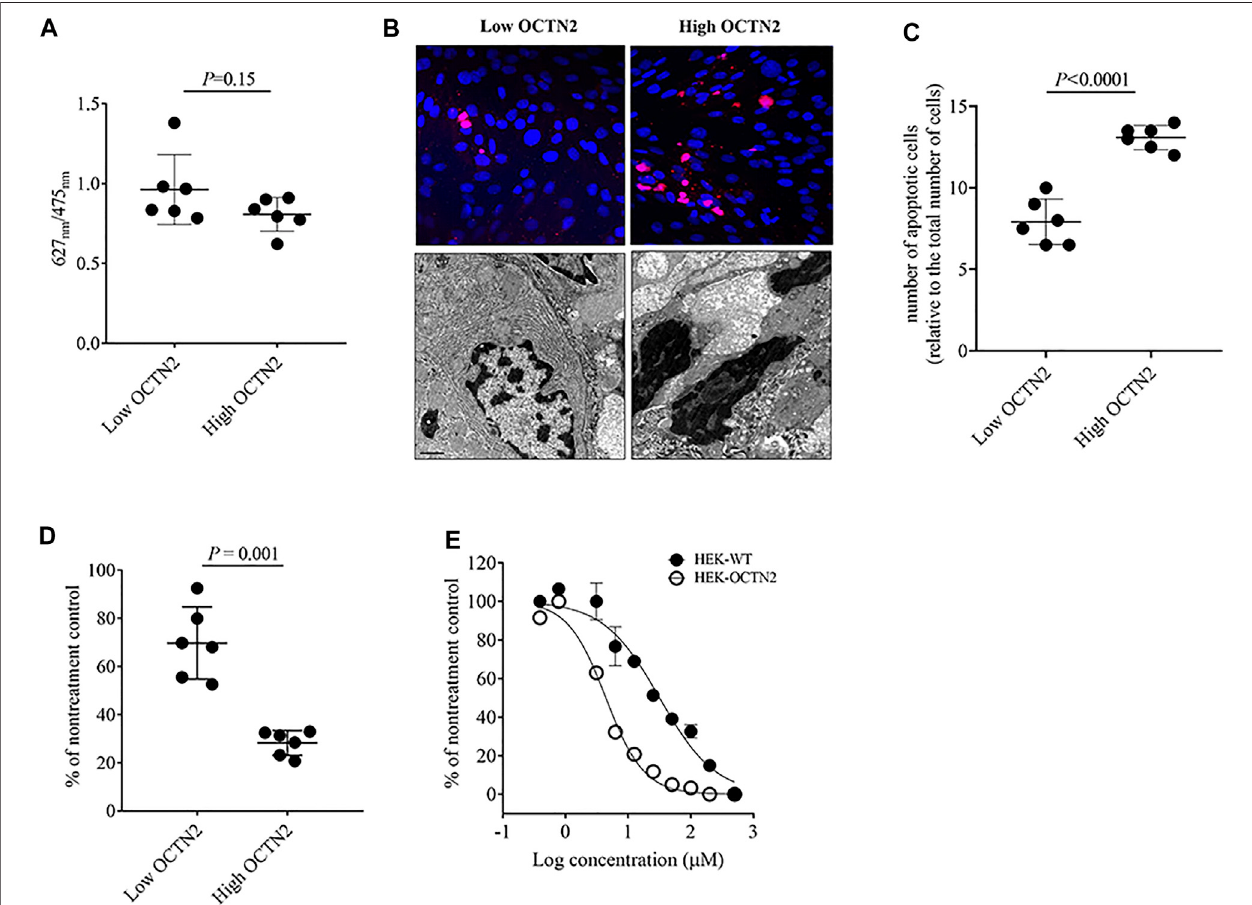
FIGURE 2 | Cell growth and oxaliplatin sensitivity in OCTN2 expressing cells. Cells were grouped according to the tissue staining score and western blot quanti fi cation. BrdU incorporation intheDNA ofOCTN2 high-and low-expressing cancercells (A) .Representative image ofTUNEL staining( (B) , toppanel) ofhigh-and low-expressingcancercellsafter48-hexposuretooxaliplatinattheextracellularconcentrationof100 µM.Representativeimageelectronmicroscopy( (B) ,bottompanel) of patient-derived cancer cells after 48-h exposure to oxaliplatin at the extracellular concentration of 100 μ M at 10,000x. Quanti fi cation of the number of apoptotic cellsstainedinpurplenormalized forthenumberofnuclei,stainedwith4,6-diamidino2-phenylindole (DAPI)inblue (C) .ATPcontentinOCTN2 high-andlow-expressing patient-derived cancer cells after 48-h exposure to oxaliplatin at the extracellular concentration of 100 µM (D) . ATP content in HEK-WT and HEK-OCTN2 exposed for 48 h to increasing extracellular concentrations of oxaliplatin (E) . All data are presented as mean ± S.D. from three independent experiments and compared by unpaired Student ’ s t-test. Curves were modelled using the (log (Inhibitor) vs normalized response-variable slope) equation.